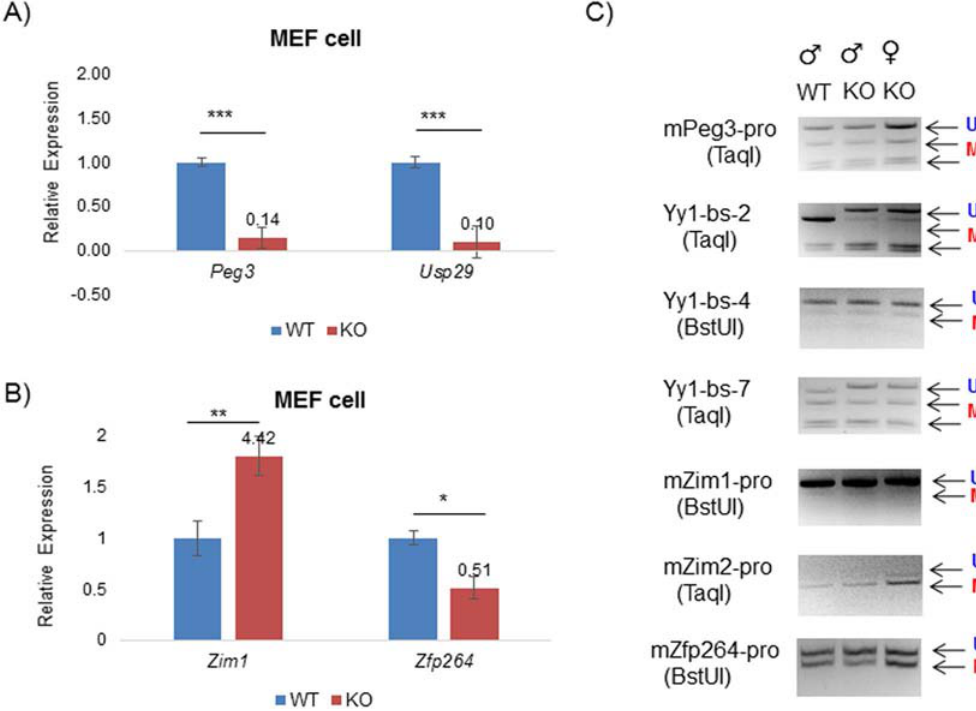
Figure 5. Mutational effects in MEF cells. ( A , B ) A set of male MEF cells (WT and KO) were used to test potential effects of the mutation on the expression levels of the imprinted genes. The expression levels of each gene were first normalized with an internal control ( β -actin), and the normalized values were further compared between the wild-types and the heterozygotes. The relative levels are presented in a graph with standard errors (S.E.). Statistical significance by Student’s t-test was also indicated in the following manner: * < 0.05, ** < 0.01, *** < 0.001. ( C ) A set of DNA isolated from male and female MEF cells were used for surveying the DNA methylation levels of the imprinted genes with COBRA. The restriction enzyme used for each set of PCR products is shown underneath of the name of each target. The unmethylation and methylation status based on the digestion pattern by a given restriction enzyme is also indicated by blue U and red M letters with arrows, respectively. The original gel images for the gel pictures are available as Supplemental material